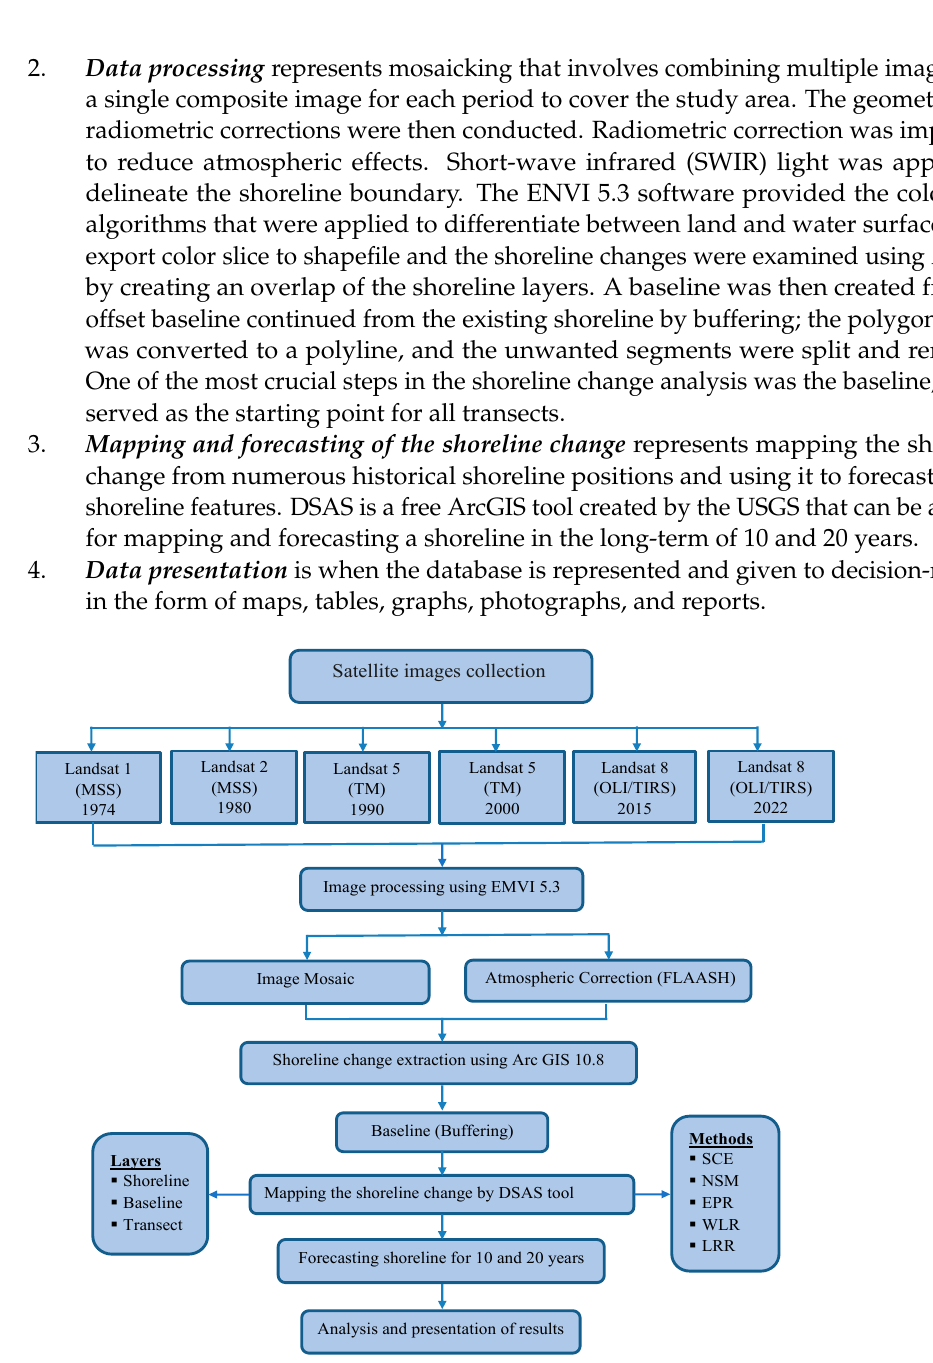
Figure 3. Methodological fl ow chart of satellite image collection and processing.